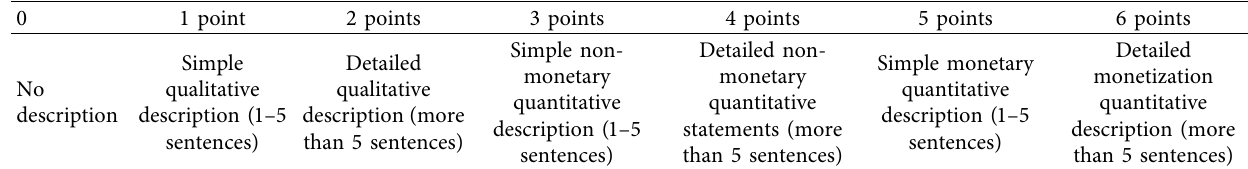
Table 12: Scoring criteria.